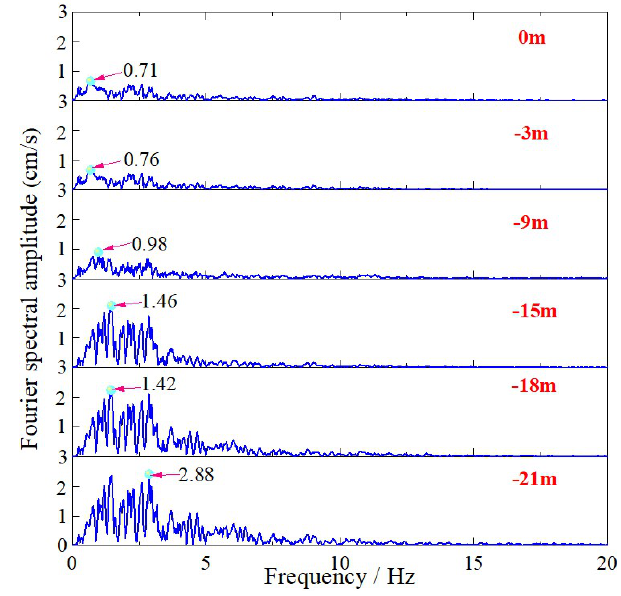
Figure 12. Acceleration Fourier spectra at different depths under the Kobe Motion.